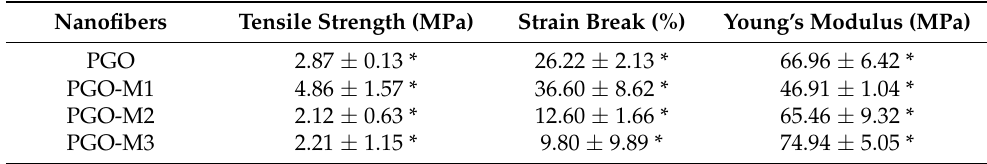
Table 2. Tensile properties of the functionalized PGO